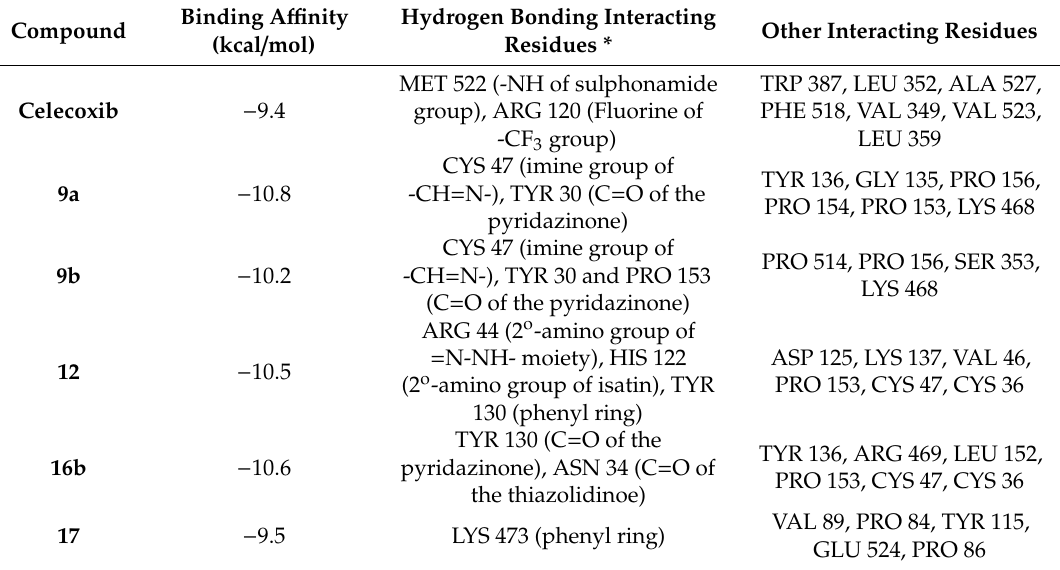
Table 4. Molecular docking data of 9a , 9b , 12 , 16b , and 17 .